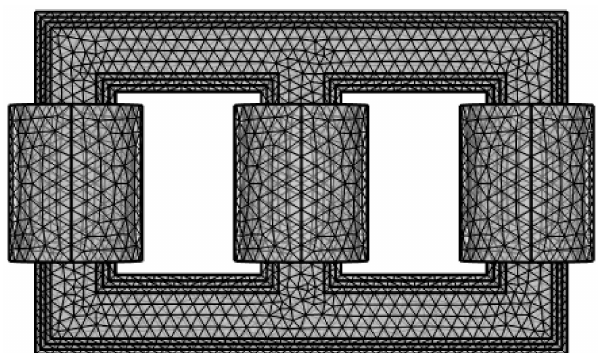
Figure 8. Developed